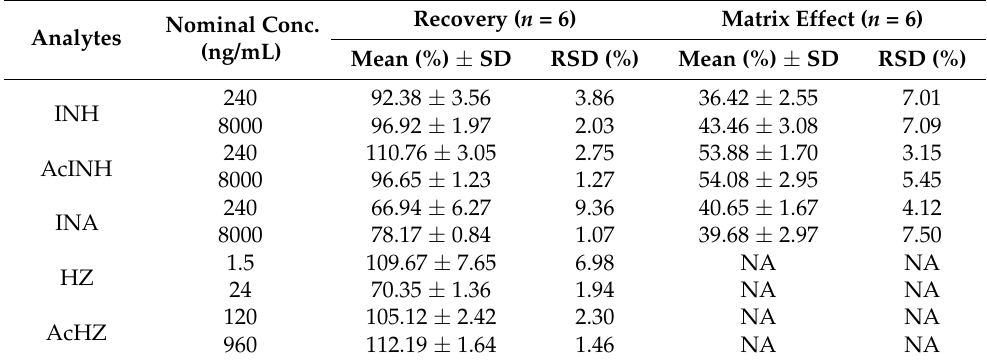
Table 3. Recovery and matrix effects of all